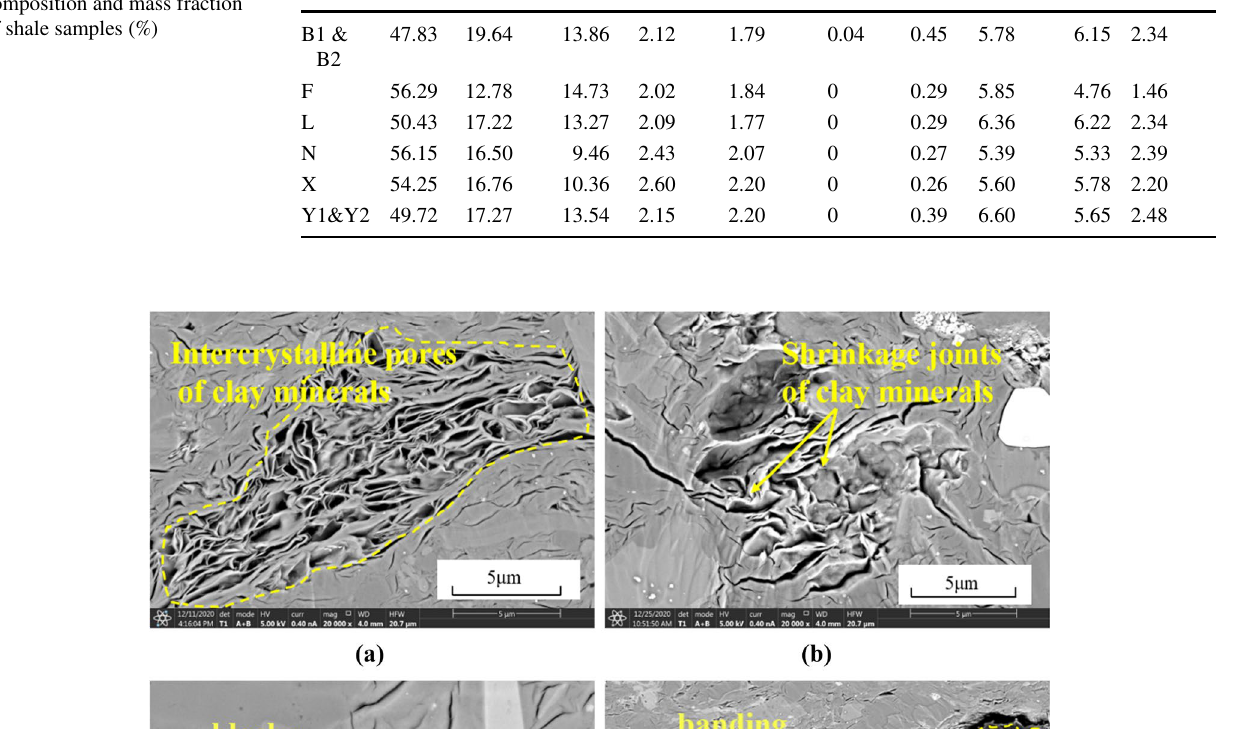
composition and mass fraction of shale samples (%)